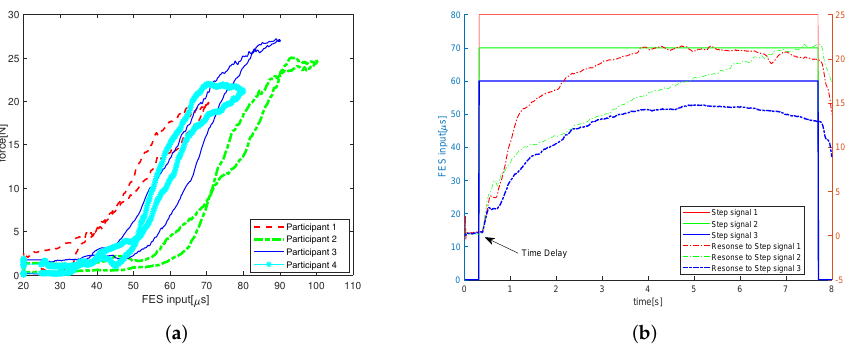
Figure 4. Experiments for model parameters identification. ( a ) Sinusoidal response of four partic- ipants. ( b ) Time delay under different FES control input (The primary axis ( left ) and second axis ( right ) represent the control input and the force signal,